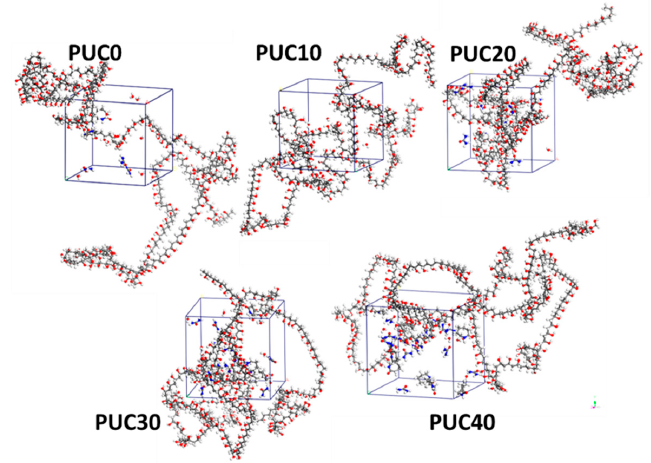
Figure 3. The equilibrium conformations of PVA composites. Table 2. Final converged density (g·cm − 3 ), cell length (Å) and cell volume (Å 3 ) of the equilibrium conformations in the PVA composites.